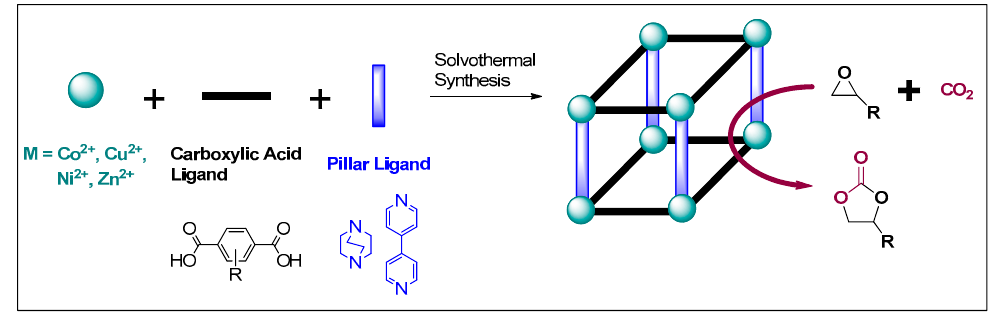
Figure 1. Three components in pillared metal-organic frameworks (MOFs) and CO 2 cycloaddition.